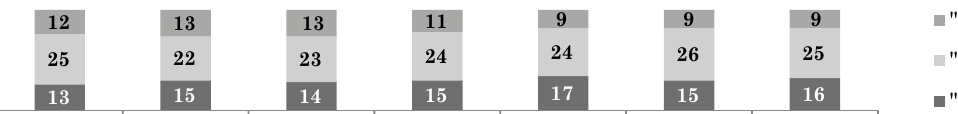
Fig. 4. Information obtained per project design